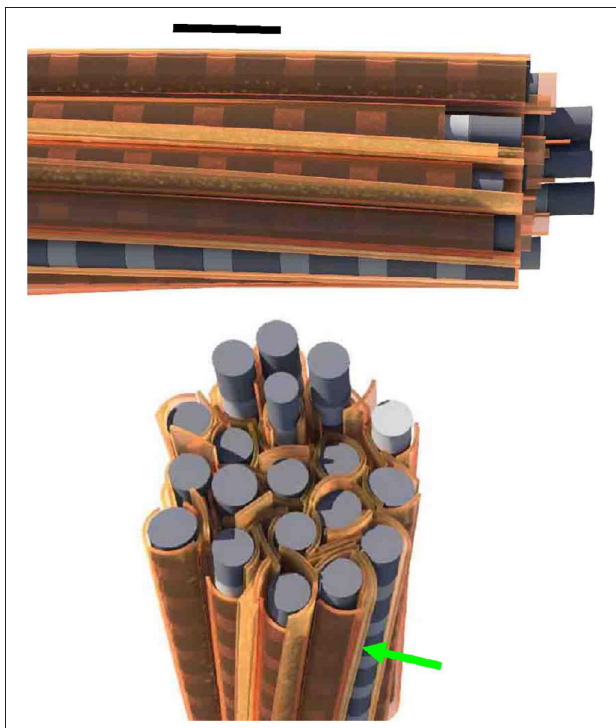
FIGURE 8 | Conceptual model for the ultrastructure of bone, from Schwarcz et al. [49]. Scale = 100